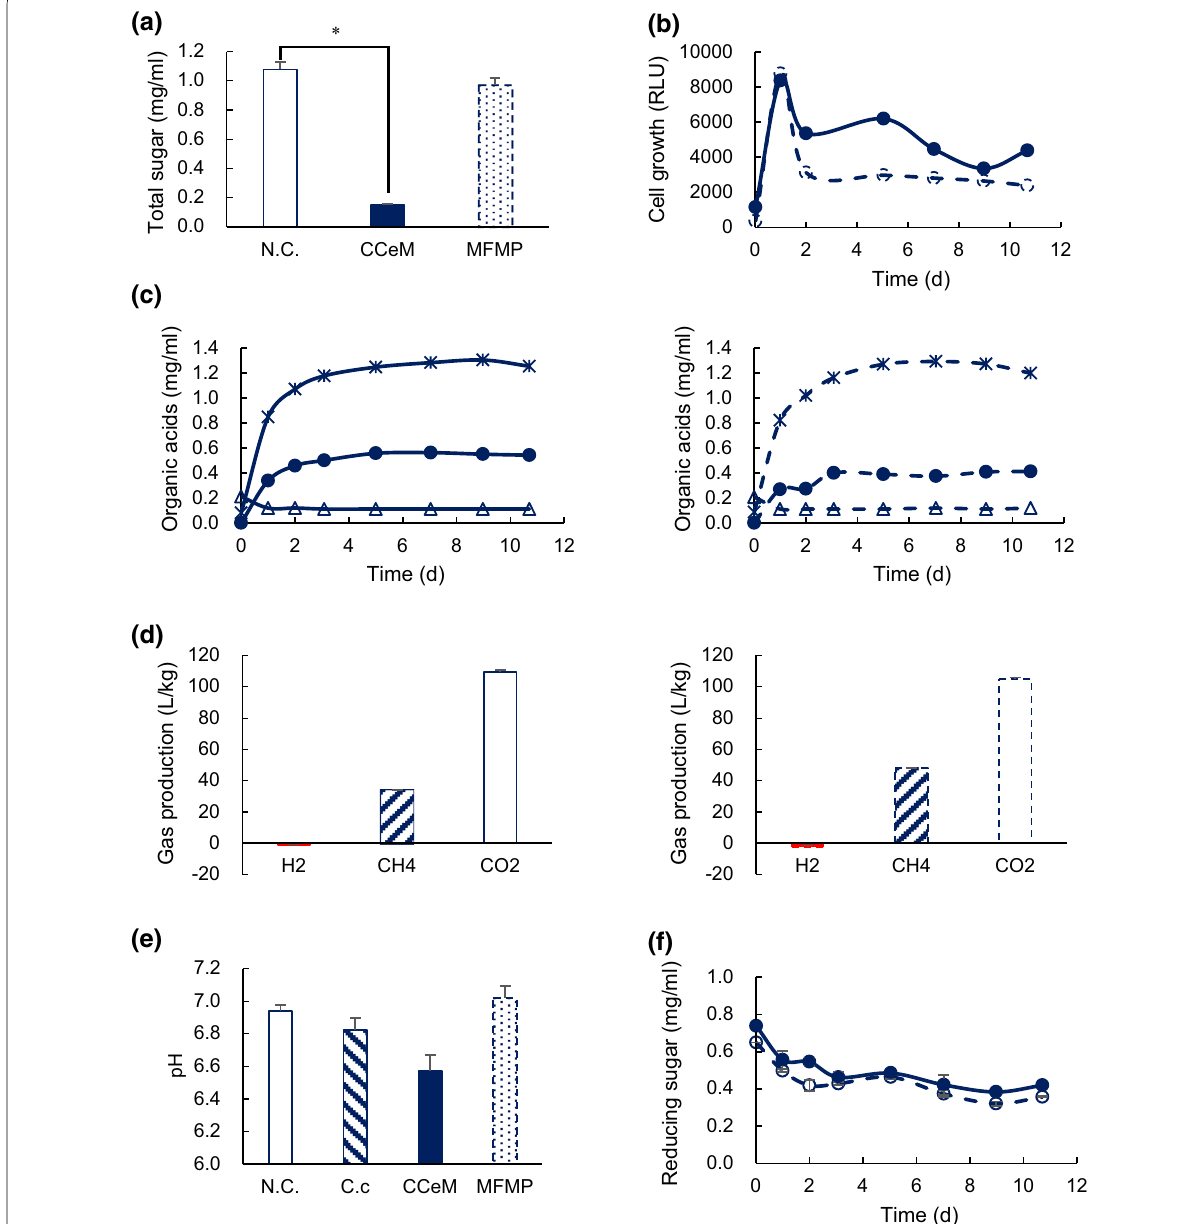
Fig. 4 Cultivation of C. cellulovorans , CCeM and MFMP with SBP. a Total sugar concentration after 11-days cultivation in the culture with SBP, where negative control (open bar), CCeM (closed bar), MFMP (dotted bar) are included. b Cell growth in the culture of CCeM and MFMP with SBP, where CCeM (open circle), MFMP (closed circle). c Organic acid concentration in the CCeM (left) and MFMP (right) cultures with SBP, where lactic acid (Δ), acetic acid (*), butyric acid (black filled circle) are included. d Gas production after 11-days cultivation in the CCeM (left) and MFMP (right) cultures with SBP, where H 2 (closed bar), CH 4 (hatched bar), CO 2 (open bar) are included. Values indicate increments from the volume of negative control and are calculated as the volume per one kg of dry weight of SBP. e pH after 11-days cultivation with SBP, where negative control (open bar), C. cellulovorans (hatched bar), CCeM (closed bar), MFMP (dotted bar) are included. f Concentration of reducing sugar in the CCeM and MFMP cultures with SBP, CCeM (closed circle), MFMP (open circle). Values with error bars are mean SE of three independent samples. An asterisk indicates a ± significant difference (p <